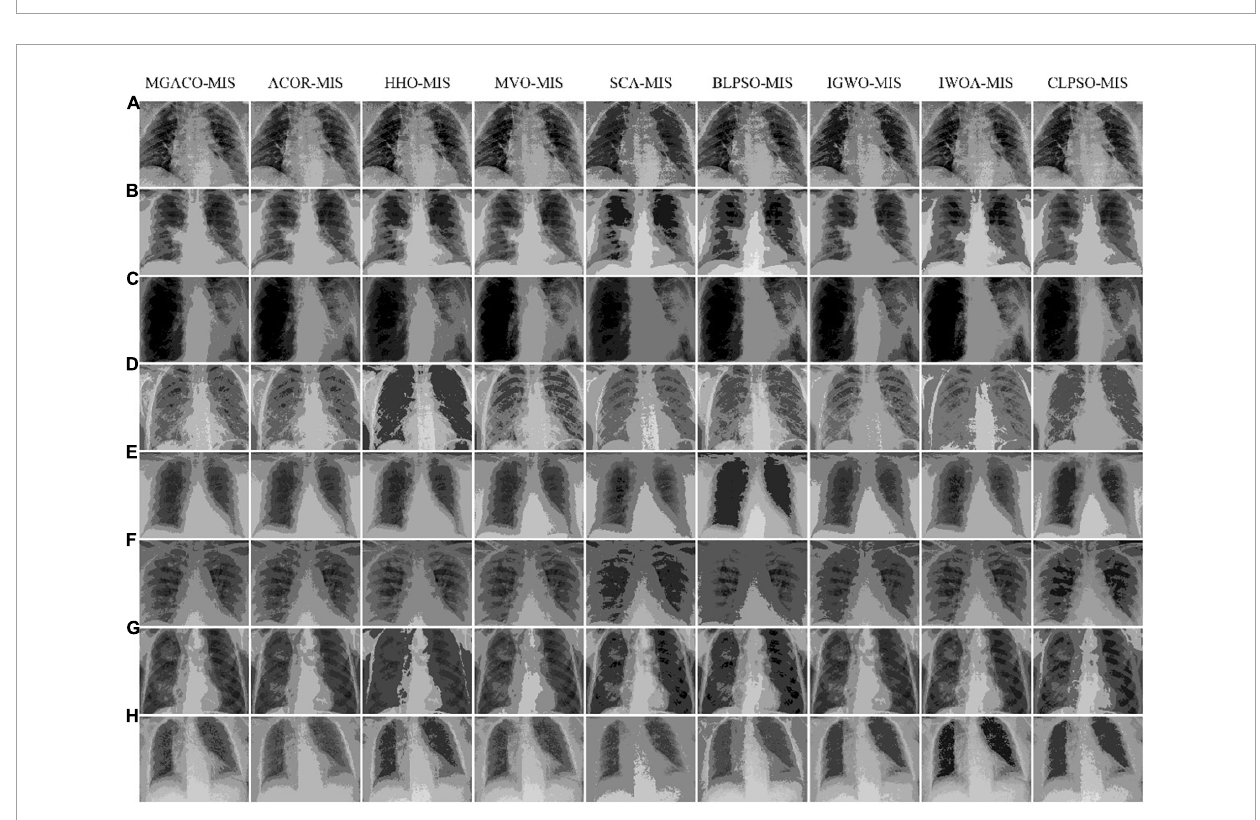
FIGURE12 Segmentation results by using 2D Kapur’s entropy for all methods at threshold level